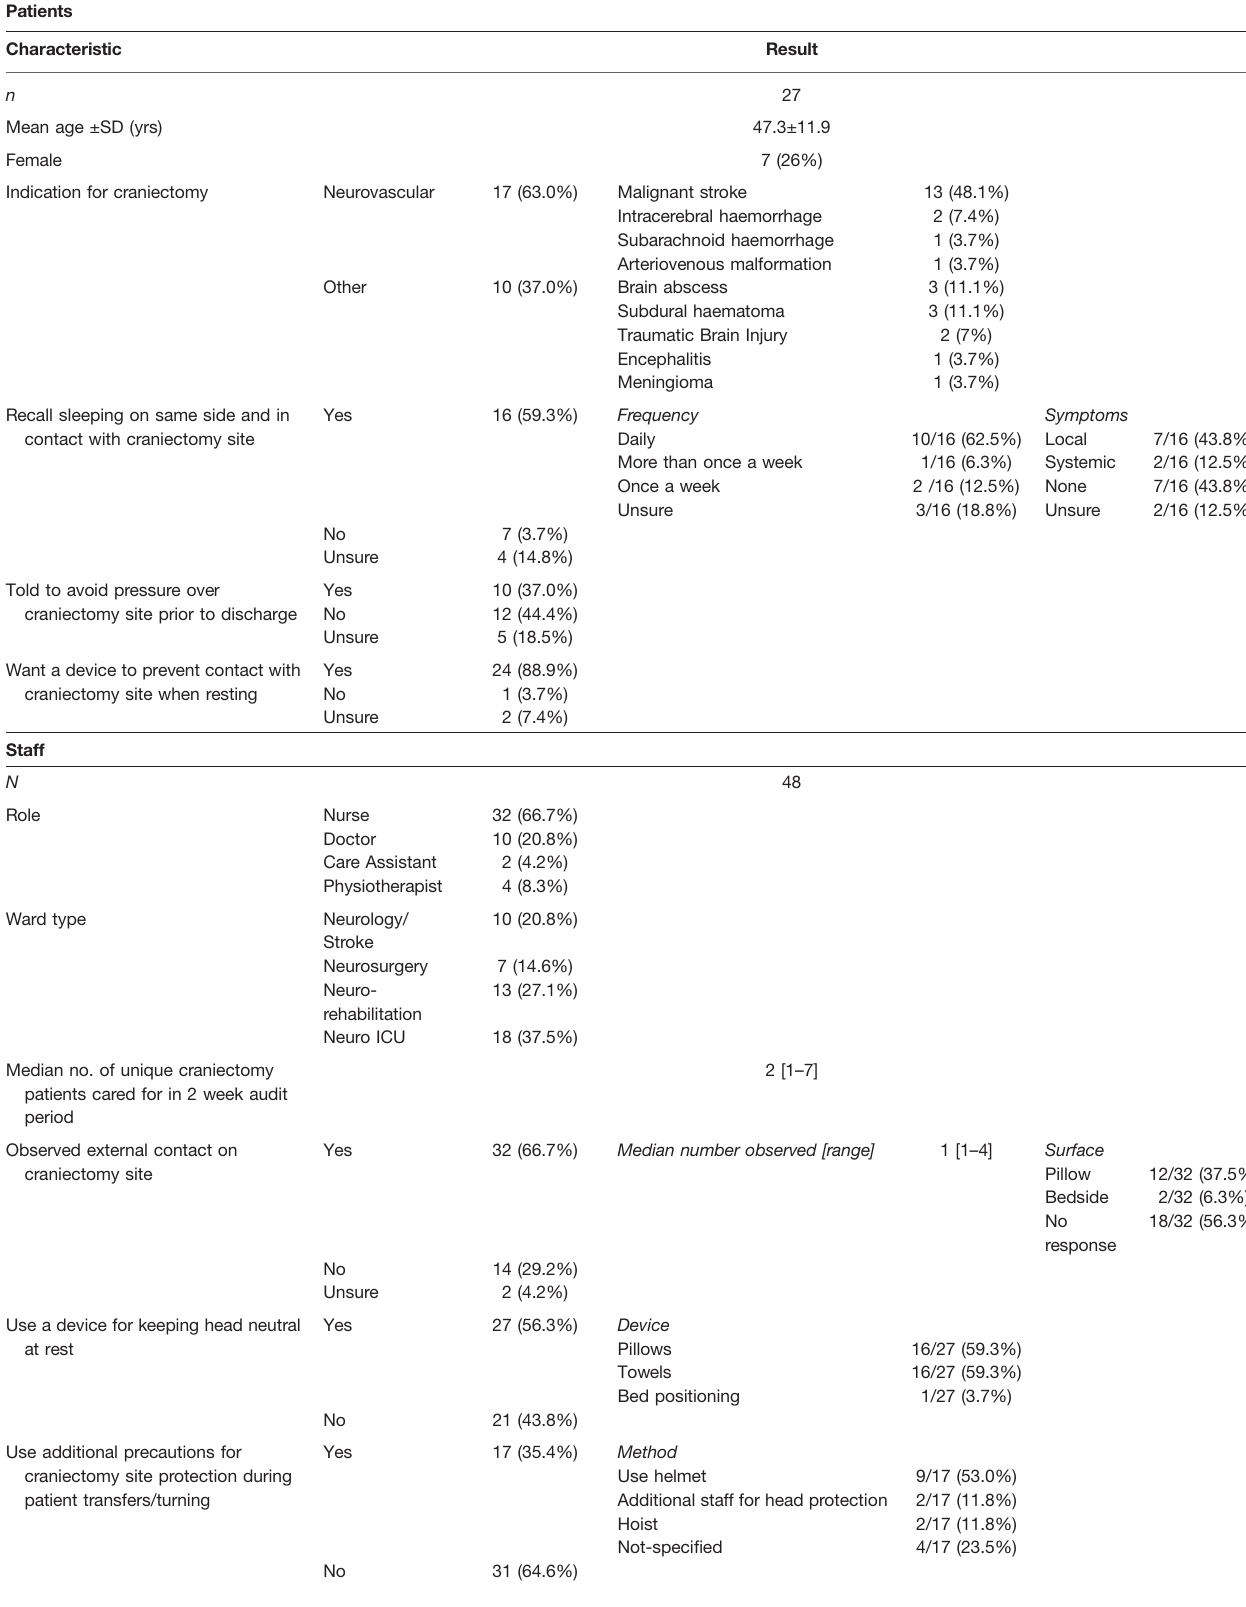
TABLE 1 | Patients and staff responses regarding craniectomy site contact, its consequences and use of devices to mitigate this risk.